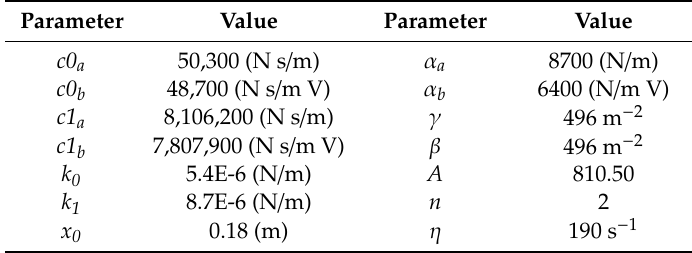
Table 2. MR damper parameters [32,40].